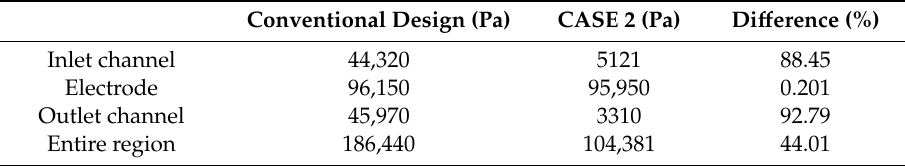
Table 7. The di ff erence in pressure drop between conventional design and CASE